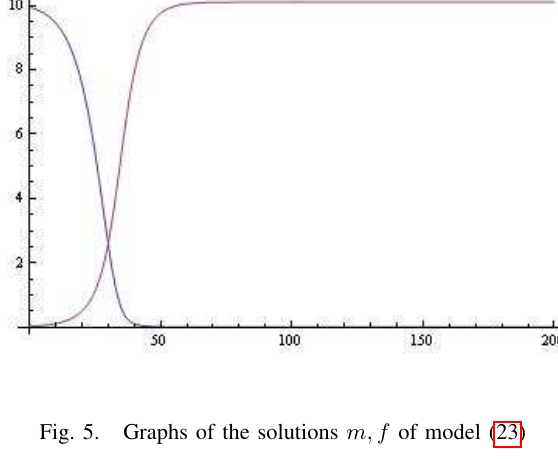
Fig. 5. Graphs of the solutions m, f of model